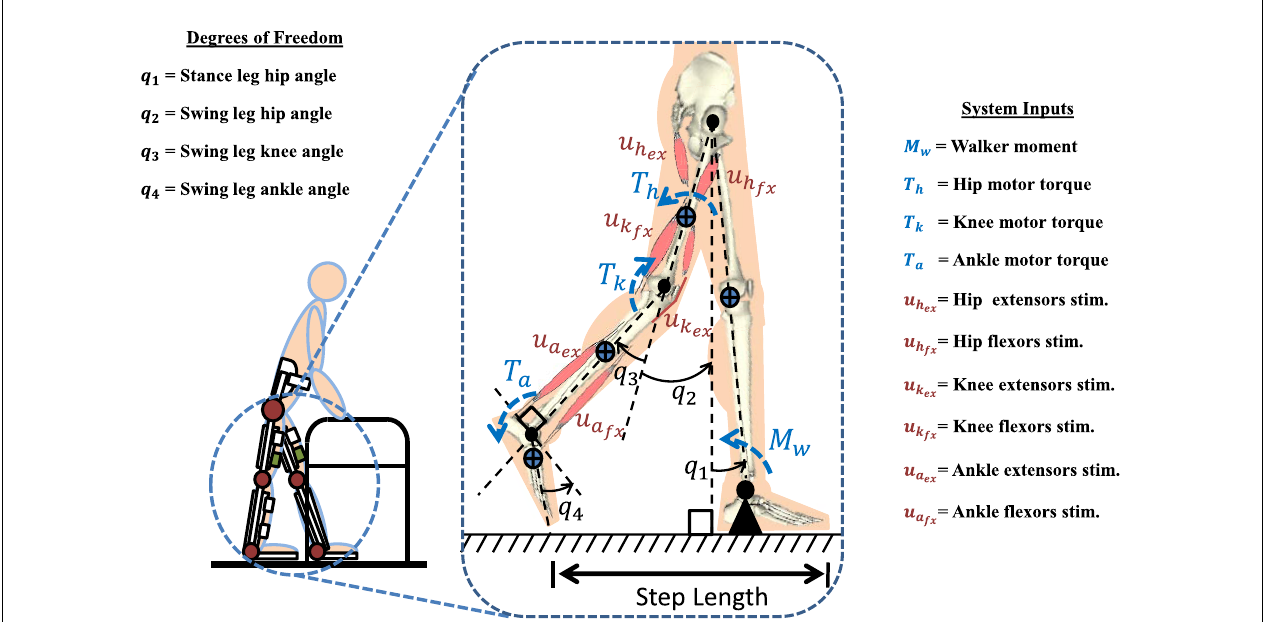
FIGURE 1 | A four-link gait model based of a subject wearing a hybrid neuroprosthesis while using a walker . The model has 10 inputs, including FES of six muscles (antagonistic hip, knee, and ankle muscle pairs in the swing leg), three electric motors acting on each joint of swing leg ( T h , T k , T a ), and a walker moment acting on the stance leg ( M w ). The step length is defined as the distance from stance toe to swing toe.